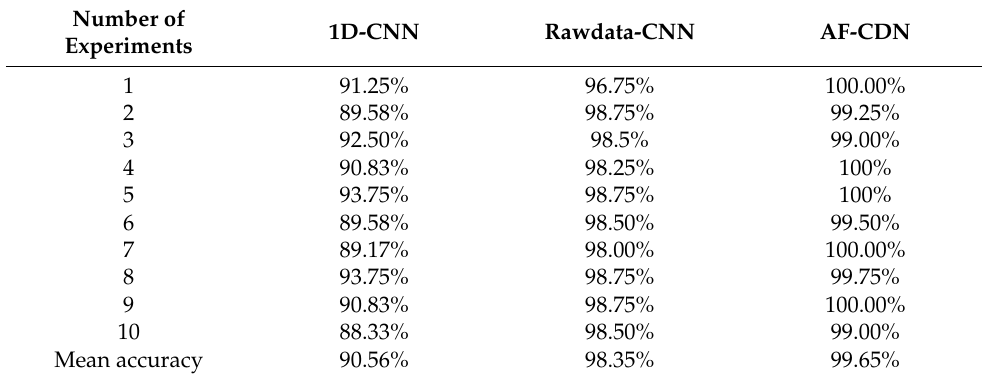
Table 2. Comparison of accuracy.